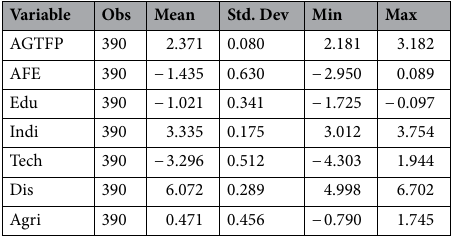
Table 1. Descriptive statistics of